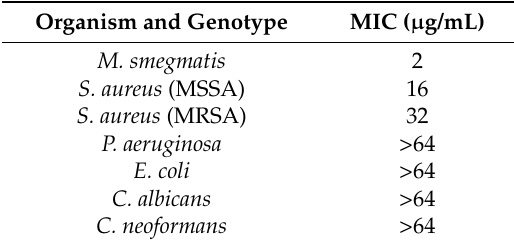
Table 1. Activity of 3 against pathogenic microorganisms.